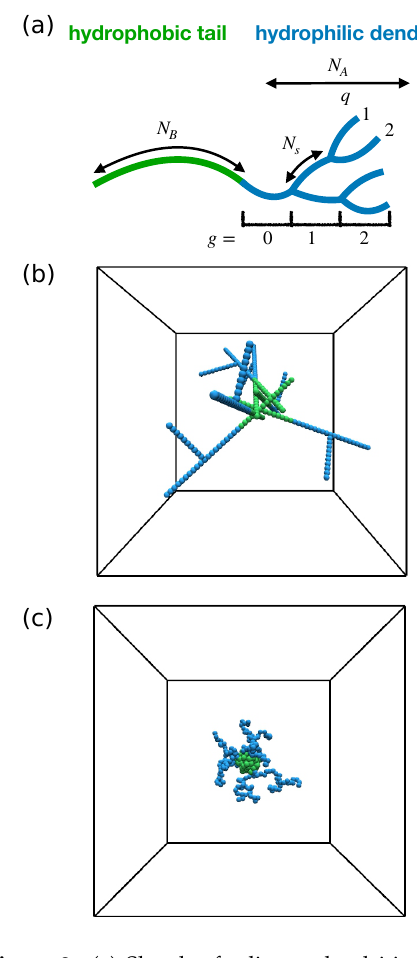
Figure 2. ( a ) Sketch of a linear–dendritic block copolymer. ( b ) Exemplary initial configuration. ( c ) Exemplary micelle at